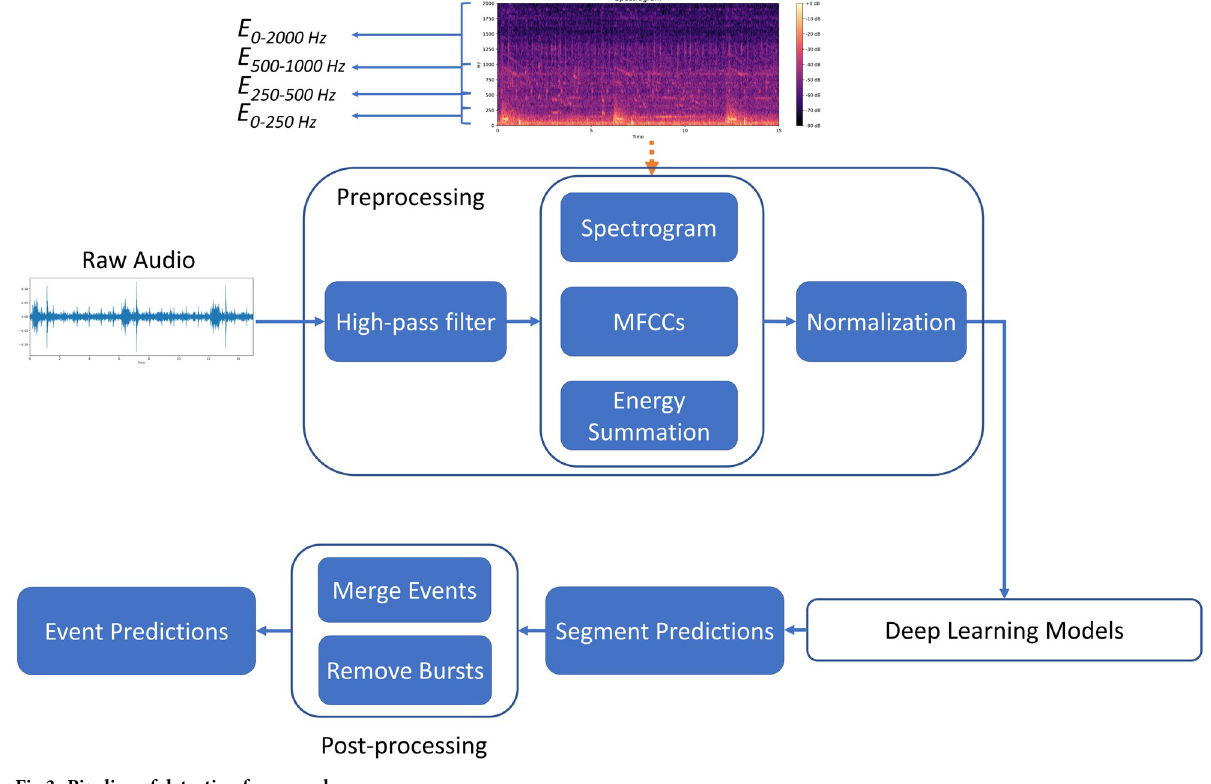
Fig 3. Pipeline of detection